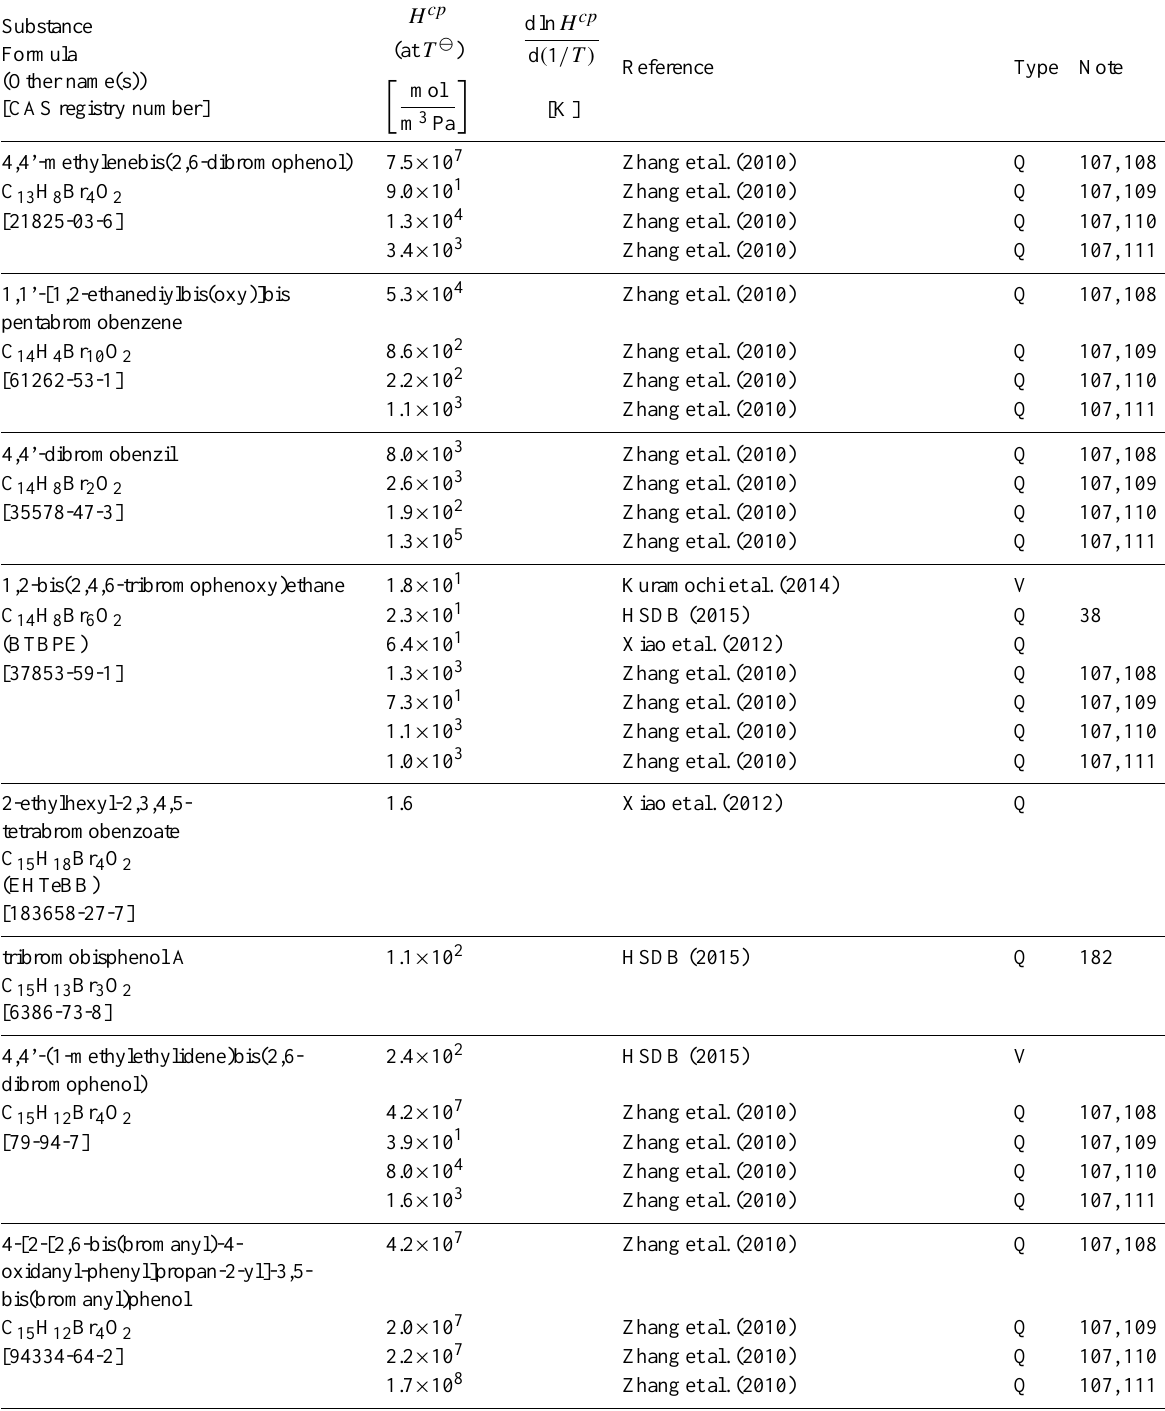
Table 6: Henry’s law constants for water as solvent